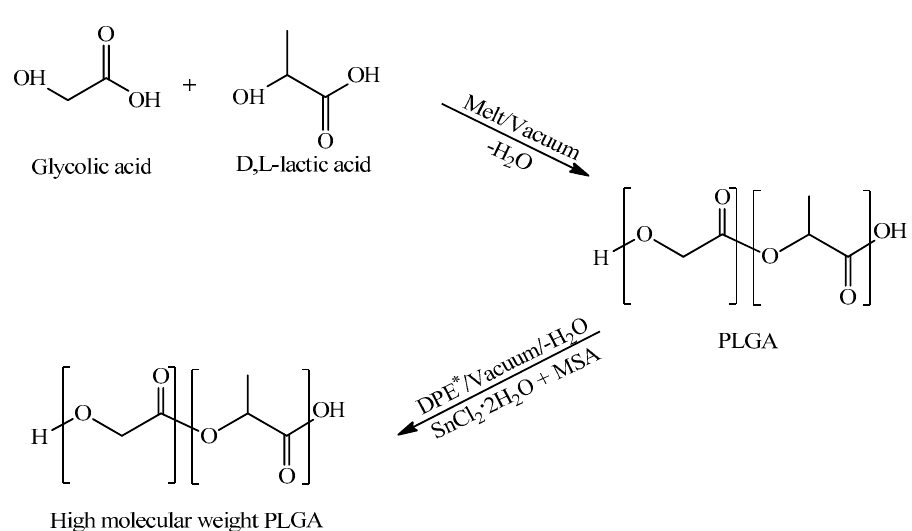
Figure 1. 1 H NMR analysis of by-products collected during synthesis of poly(lactide- co -glycolide) (PLGA) copolymers and pure glycolide.